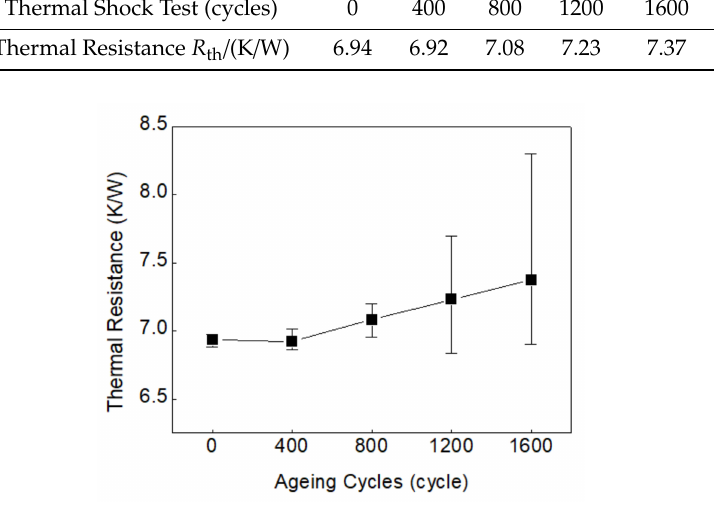
Figure 9. Thermal resistance of solder joints vs. ageing